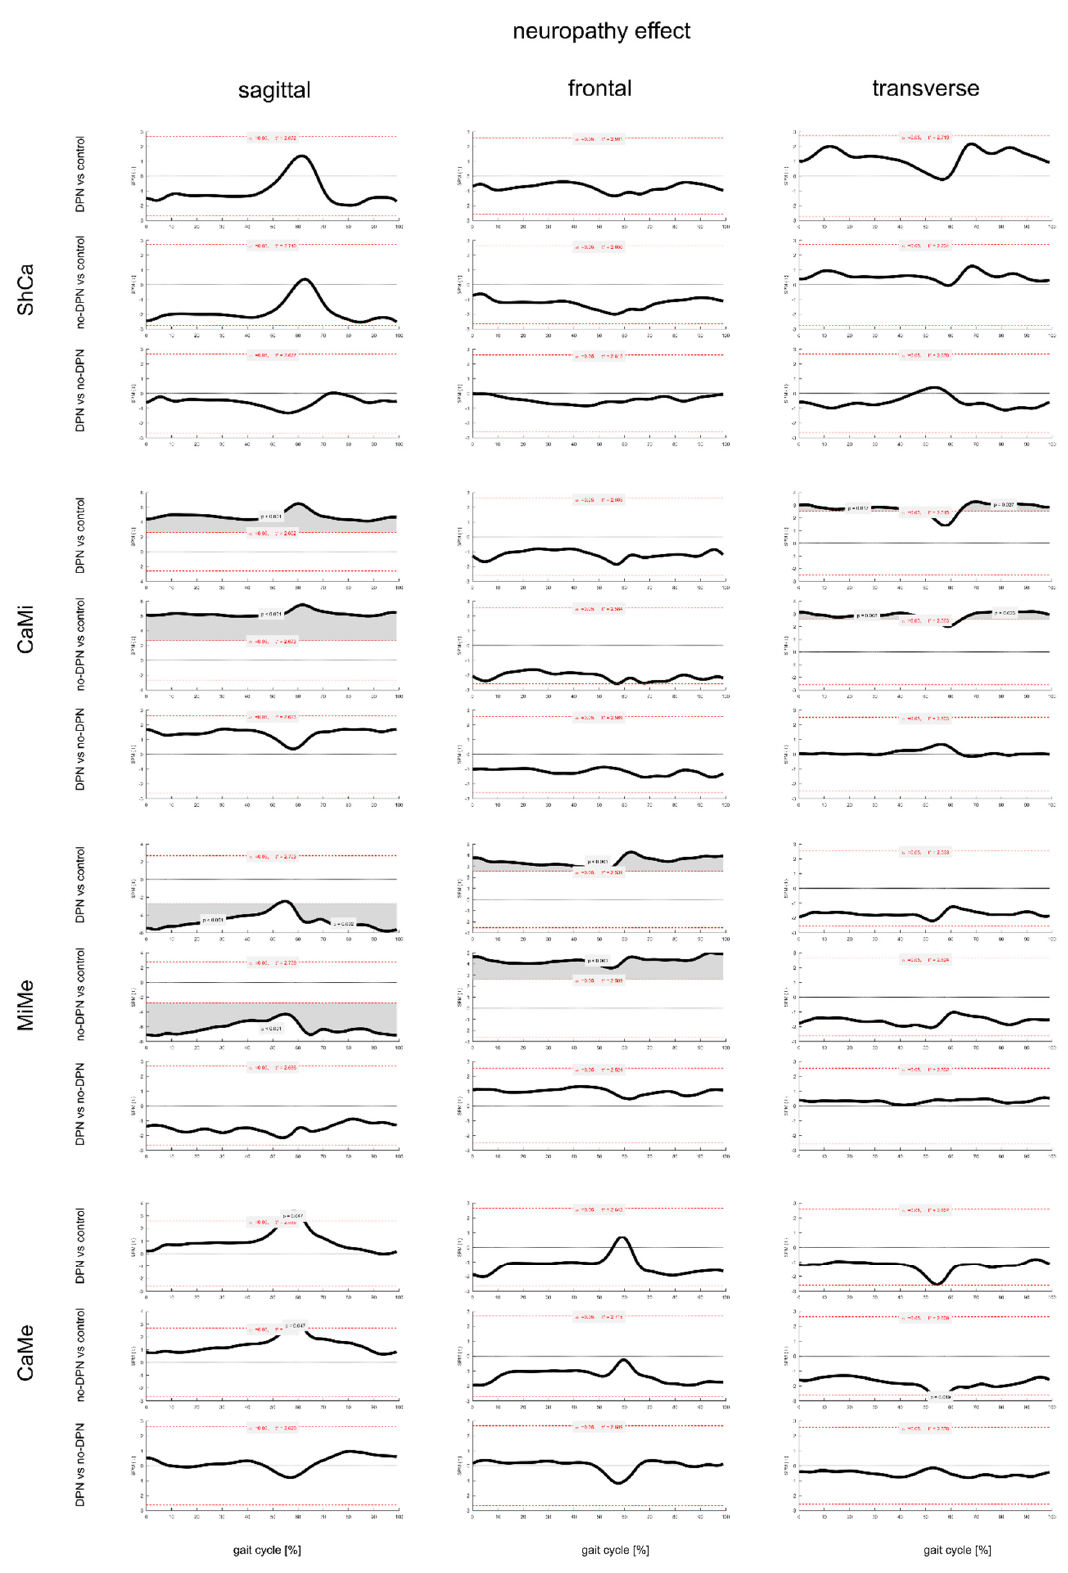
Figure 5. Outcomes of the SPM two-tailed paired t -tests which allowed to identify supra-threshold clusters of SPM (t) for the pairwise comparisons between temporal profiles of joint rotations in neuropathic (DPN), non-neuropathic (non-DPN) and control. Time intervals of statistically significant differences ( p < 0.05) between groups are shown in grey.